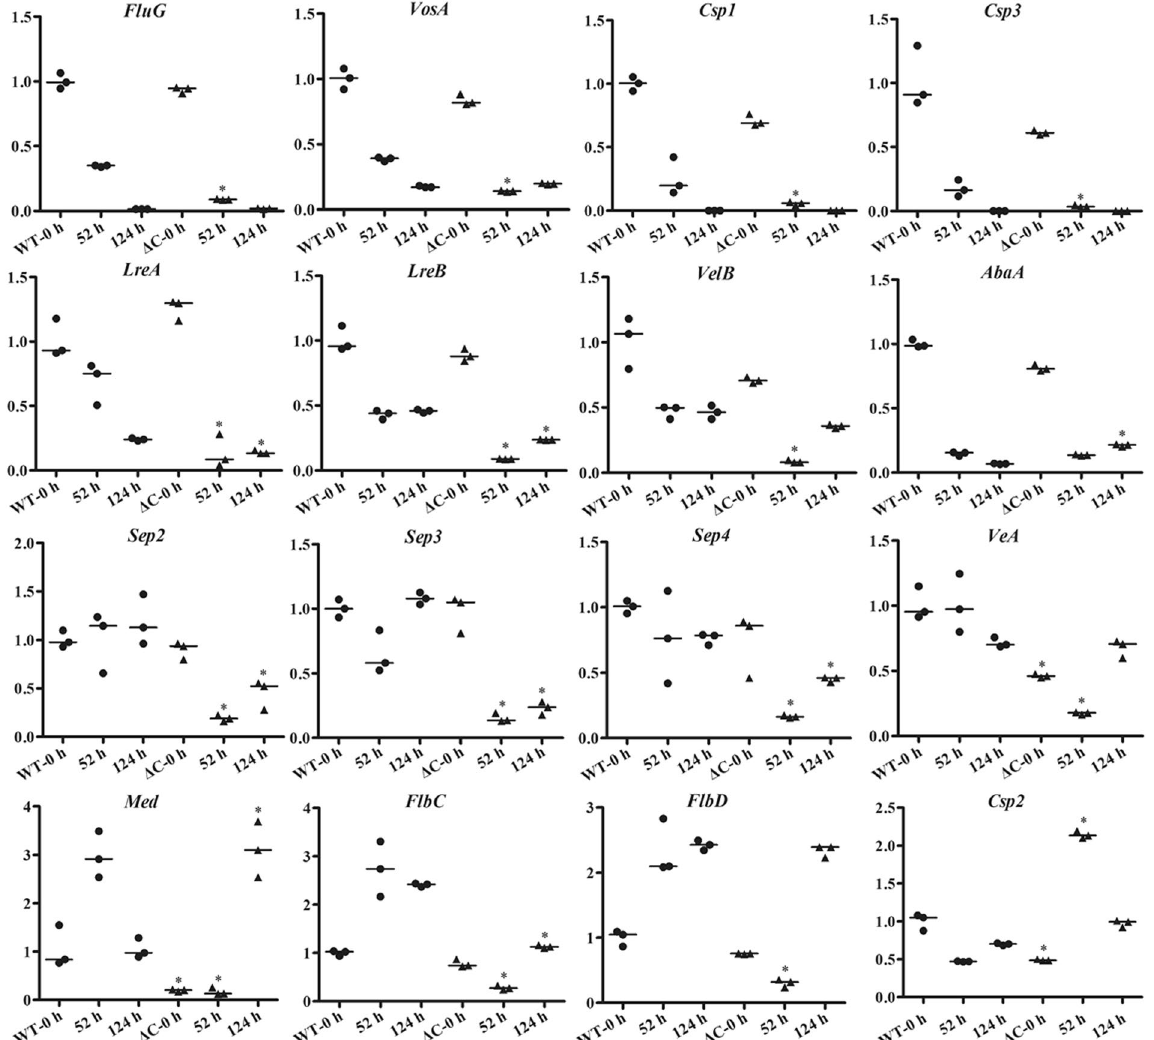
Figure 8. Transcriptional analysis of sporulation-related genes in WT and mutant Δ c at different times. The horizontal axis shows the culture times of the WT and mutant Δ c , and the vertical axis shows the relative transcriptional levels of each gene at indicated time (0 h, 52 h and 124 h, respectively). The black dots show the WT, and the black triangles show the mutant Δ c . The GenBank nos. of sporulation-related genes and their annotations can be found in Supplementary Table S3. β -tubulin gene (AOL_s00076g640) of A. oligospora was used as the internal control. * P < 0.05 Δ c versus WT. The horizontal bars depict the median, and data are presented as suggested by Weissgerber et al . 58 and Klaus 59